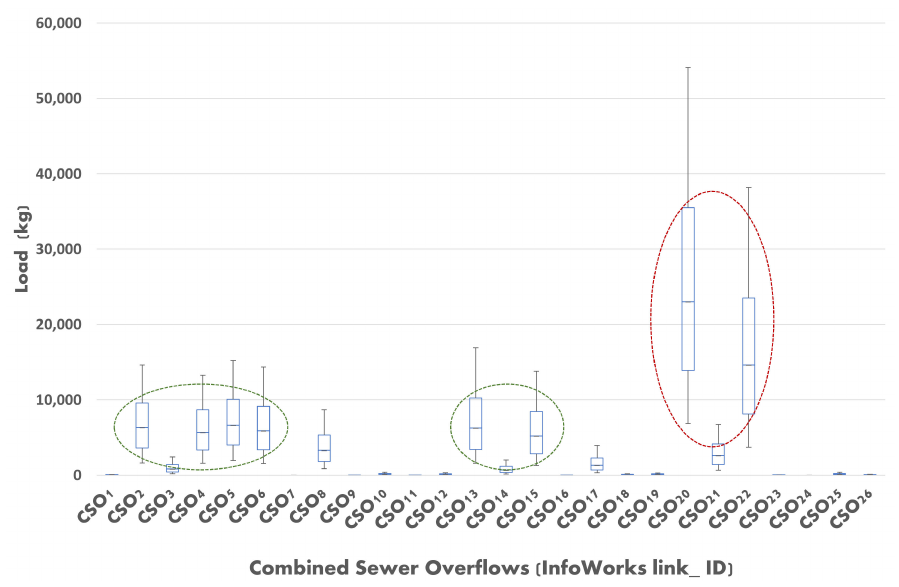
Figure 9. Cockle output: yearly emitted COD load (kg) per CSO in the Kortenberg catchment. Potential remediation urgency is indicated by red (high) and green (medium) contours.